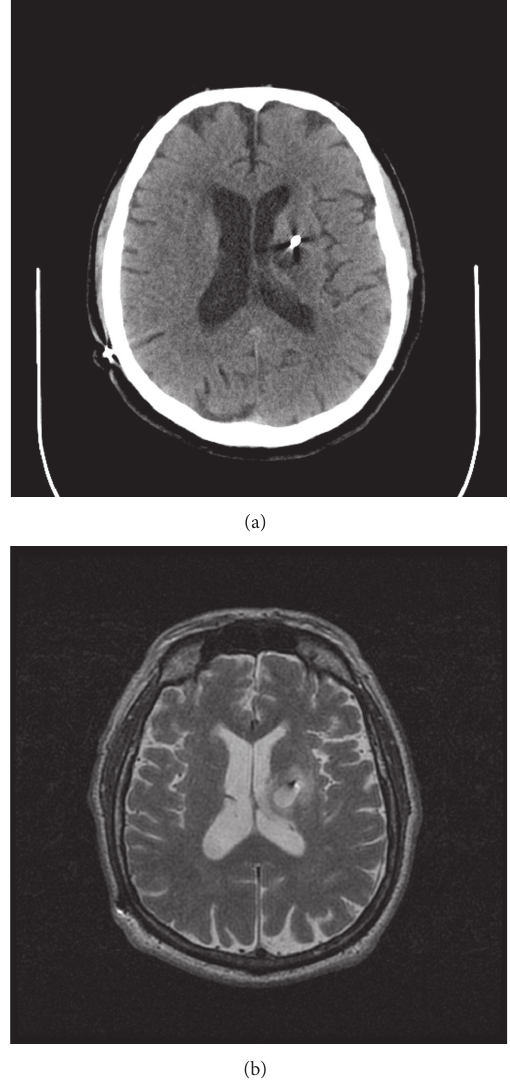
hypodense1.5cmovoidlesioninlebasalgangliasurroundingdeep